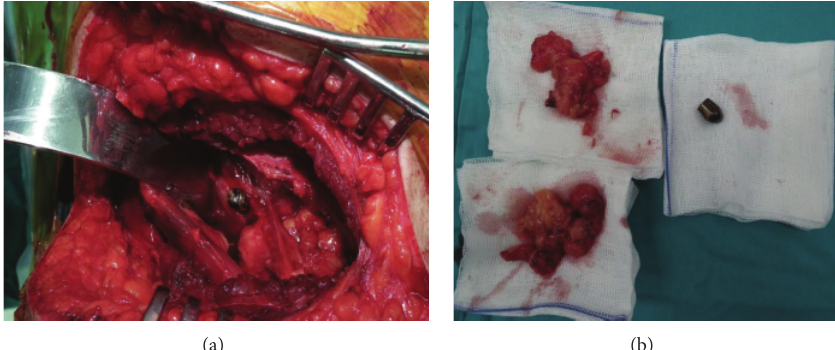
Figure 3: (a) Intraoperative view of the bullet in the iliopsoas. (b) The granulomatous tissue and bullet